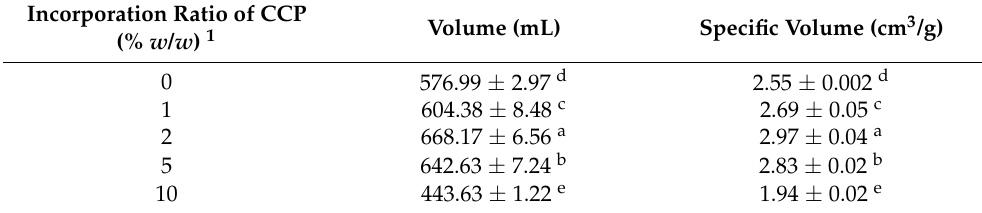
Table 4. Volume of the experimental bread